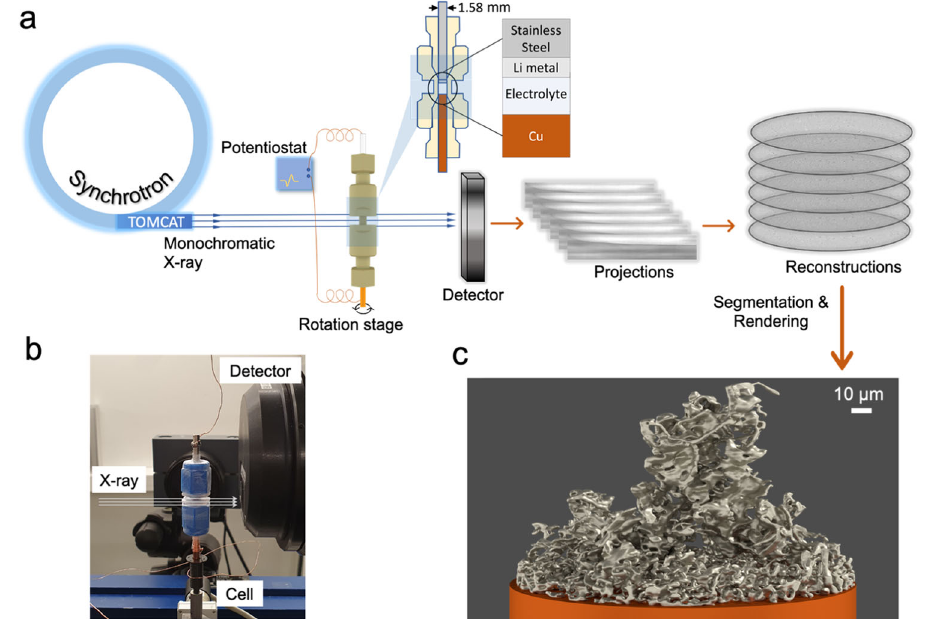
Fig. 1 | Operando X-ray tomographic microscopy. a Illustration of the operando setup, collection of projections and reconstruction. b Photographic picture of the experimental setup with the in-house developed operando cell. c Example of a 3D